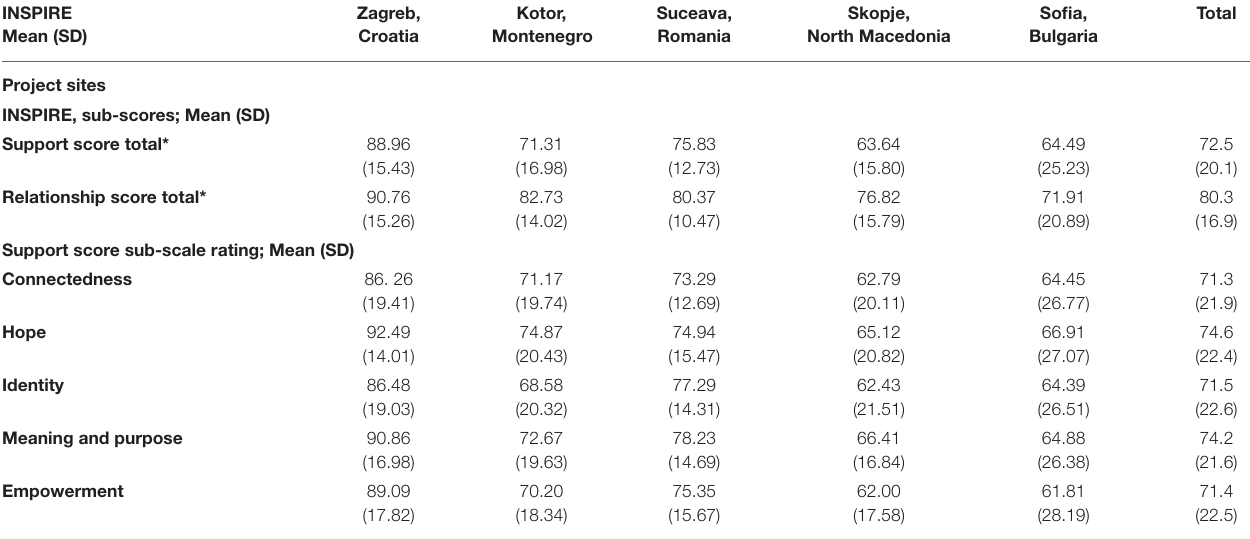
TABLE 1 | INSPIRE scores per project site and for the total sample. INSPIRE Mean